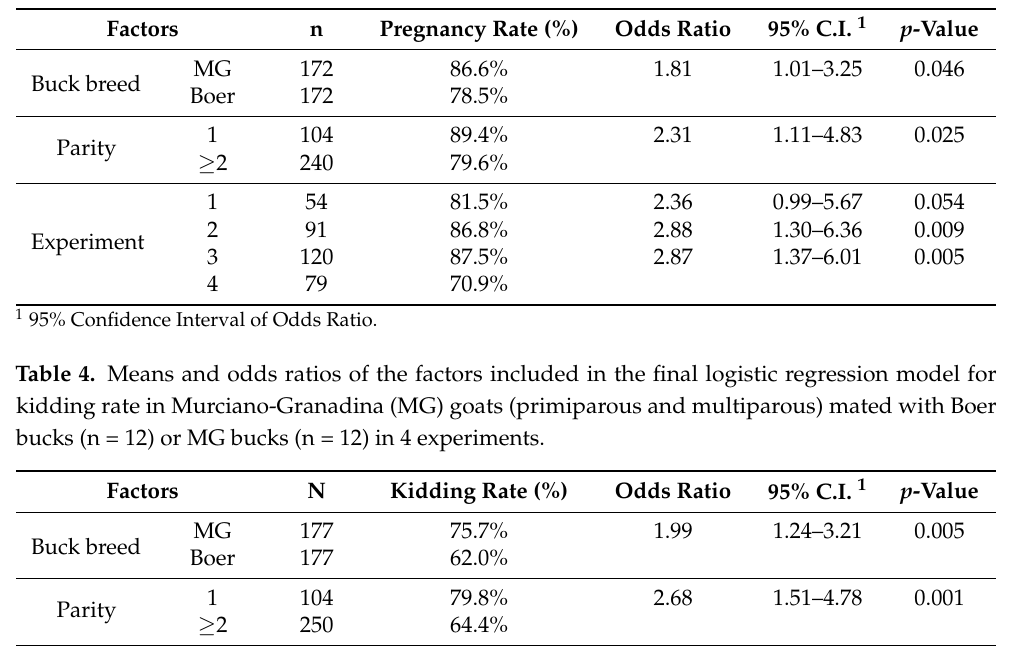
Table 3. Means and odds ratios of the factors included in the final logistic regression model for pregnancy rate in Murciano-Granadina (MG) goats (primiparous and multiparous) mated with Boer bucks (n = 12) or MG bucks (n = 12) in 4 experiments. Factors n Pregnancy Rate (%) Odds Ratio 95% C.I. 1